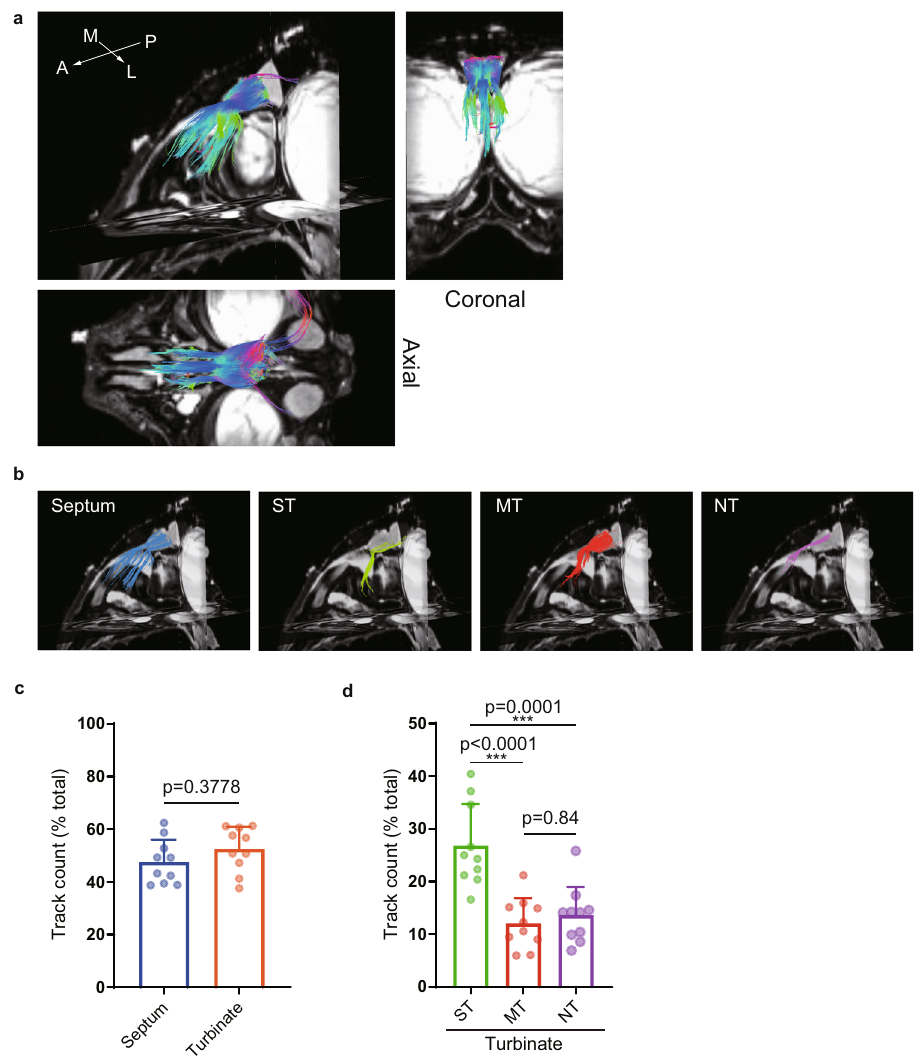
Fig. 4 The distribution of marmoset olfactory nerves depicted by diffusion tensor tractography (DTT). a DTT was performed using the whole skull of a marmoset. The reconstructed three-dimensional images show oblique-sagittal, coronal and axial views. The colored fi bers were visualized with DTT, and b0 images were used as the background images. The olfactory bulbs of the marmoset were set as the region of interest (ROI) so that the depicted fi bers re fl ected the neurons projecting from the nasal cavity to the olfactory bulbs. The fi bers are color-coded according to their directionality: anterior-posterior axis, blue; medial-lateral axis, red; and superior-inferior axis, green. A anterior, L lateral, M medial, P posterior. b Oblique-sagittal views of the fi ber tracts projecting from the main anatomical structures in the nasal cavity. The nerve tracts identi fi ed by DTT were color-coded according to the structure selected as the ROI (septum, middle turbinate, nasoturbinate or superior turbinate). MT middle turbinate, NT nasoturbinate, ST superior turbinate. c The track counting function of TrackVis was used to measure the density of fi bers distributed in the septum and turbinates. Each value is expressed as the percentage of the total track counts. Bars show the mean and standard deviation. Individual data points are shown in dots ( n = 10; 10 nasal cavities from 5 biologically independent specimens). d The percentage of all track counts of the fi bers distributed to each of the turbinates. MT middle turbinate, NT nasoturbinate, ST superior turbinate. Bars show the mean and standard deviation. Individual data points are shown in dots ( n = 10; 10 nasal cavities from 5 biologically independent specimens). *** p <